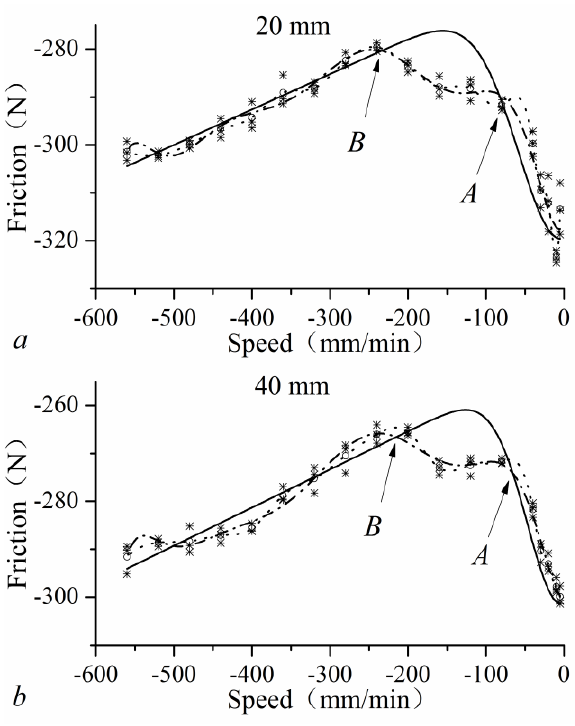
Figure 14. Comparison of the experimental data with three model curves for the forward feed. ( a ) Position of 20 mm; ( b ) Position of 60 mm; ( c ) Position of 125 mm; ( d ) Position of 135 mm; ( e ) Position of 200 mm; ( f ) Position of 300 mm.